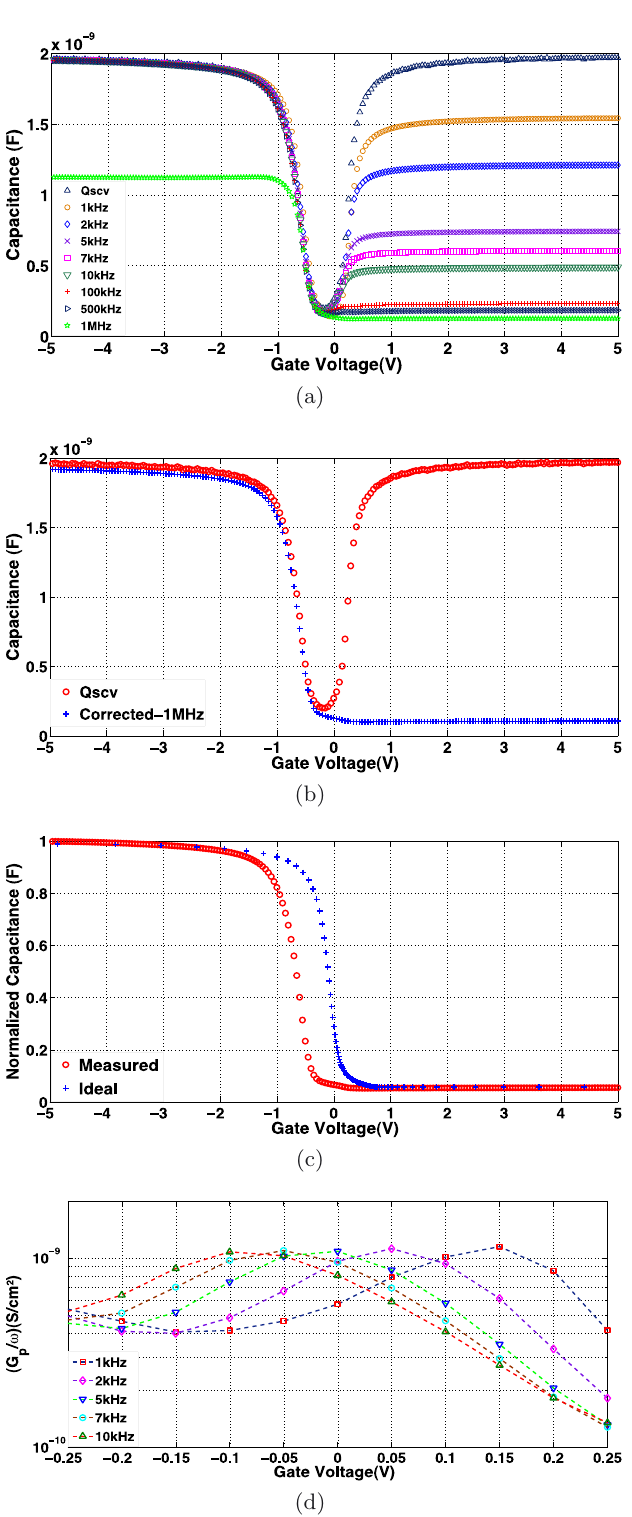
Fig. 4. PECVD-deposited SiO 2 MOS Capacitor ( C - V - G ) curves after parasitic effects correction using dual-frequency five-element circuit model: (a) C - V curves at different fre- quencies, (b) D it extraction using high-low frequency method, (c) D it extraction using Terman method, (d) D it extraction using conductance